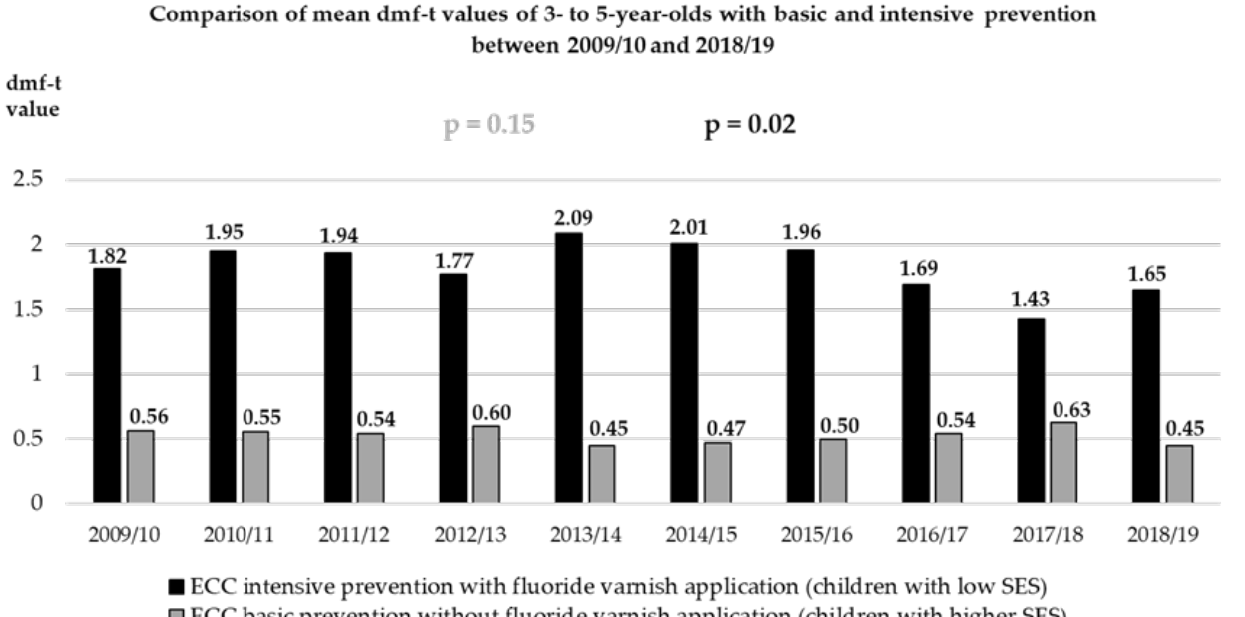
Figure 1. Long-term data from the kindergarten year 2009/10 up to 2018/19 concerning the mean caries experience in 3–5-year-old children attending different kindergartens with and without fluoride varnish application. The p–values given in the figure were calculated with a generalized linear model with ordinal dependent variable to test the linear effect of time within the kindergarten group with ECC preventive program (black) and basic prophylactic measures (grey).